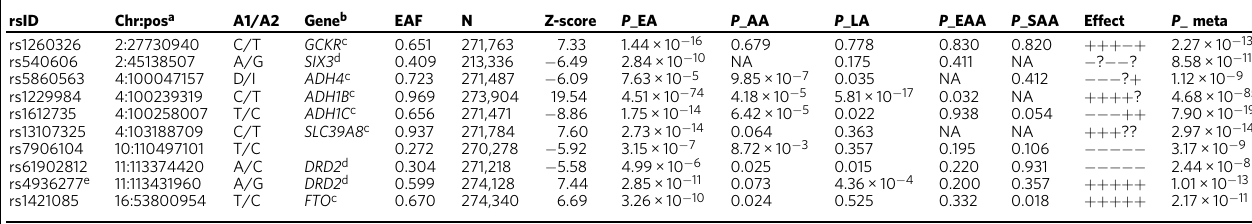
Table 2 Genome-wide signi fi cant associations for AUD in the trans-population meta-analysis rsID